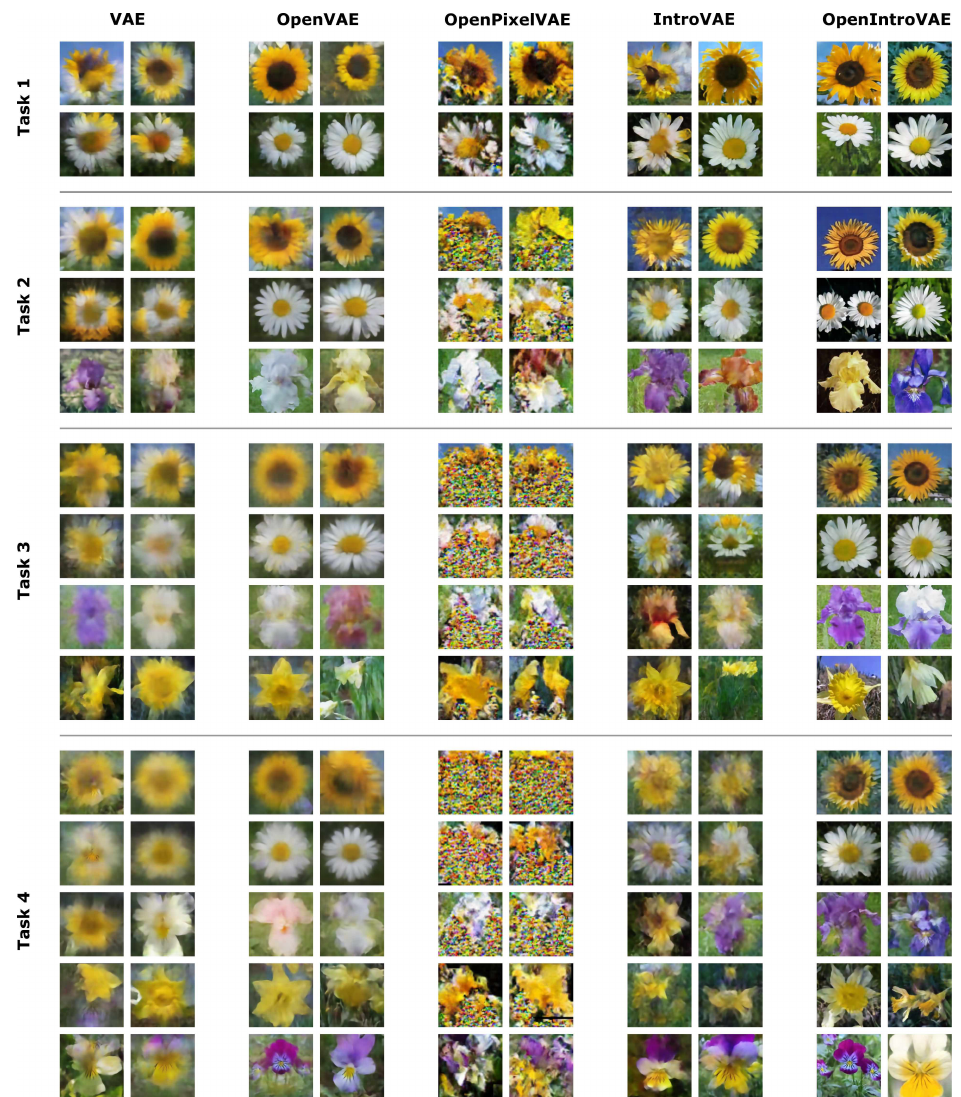
Figure 6. Generated 256 × 256 flower images for various continually trained models. Images were selected to provide a qualitative intuition behind the quantitative results of Figure 5. Images are compressed for a side-by-side